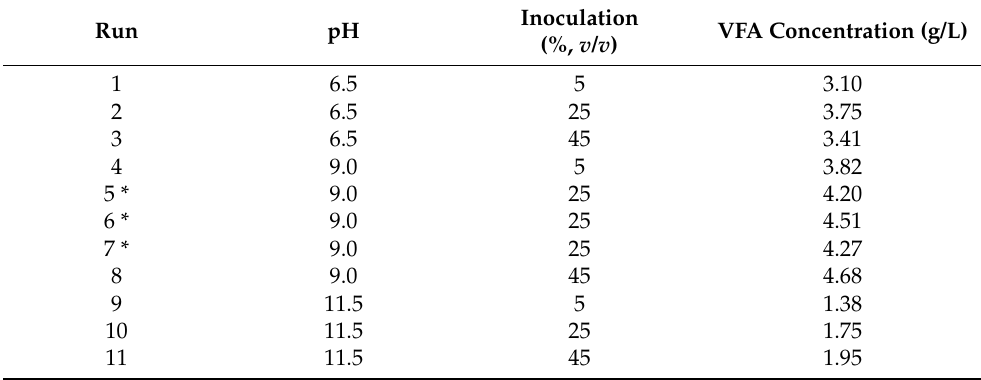
Table 1. The central composite design of the variables and experimental VFA concentrations.